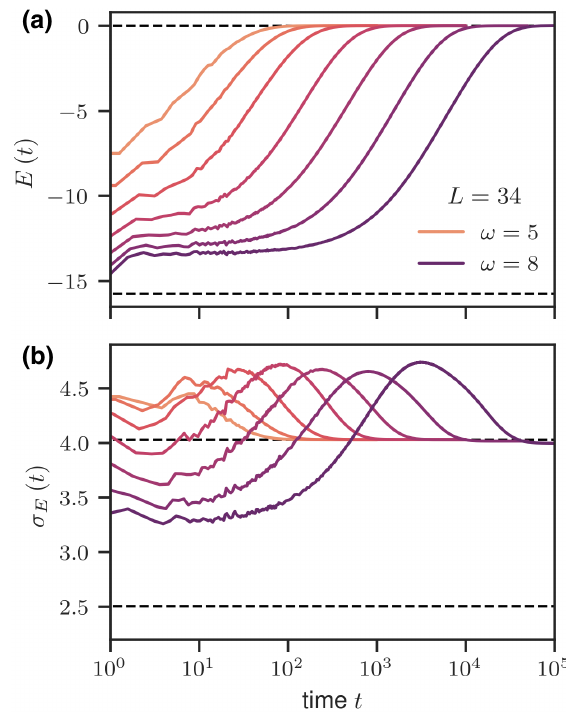
FIG. 3. The mean (a) and standard deviation (b) of the energy, with respect to ¯ H , versus time. Light to dark (left to right) curves correspond to ω ∈ [5, 8] in steps of 1 / 2. All data are for L = 34 qubits. The dashed black lines indicate both initial values